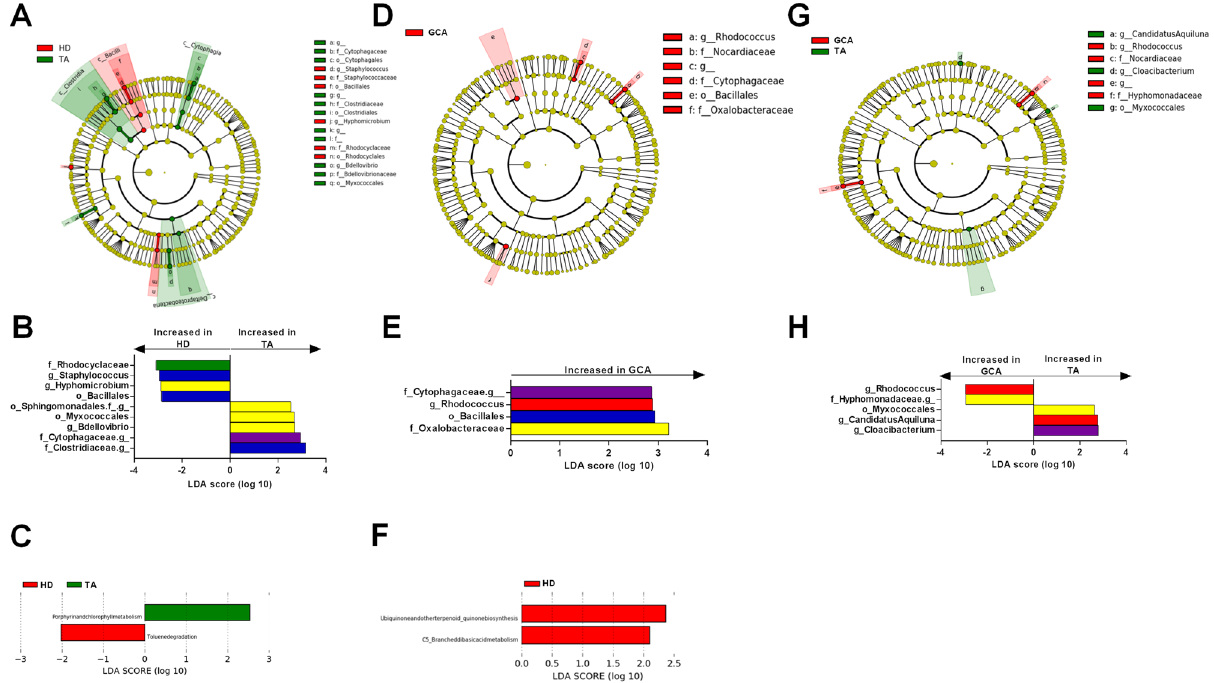
Figure 2. Circulating microbiome profile and predicted metagenomic function in patients with large vessel vasculitis depending on their phenotype. ( A ) LDA effect size (LEfSe) cladograms showing the taxa most differentially associated with TAK patients (n = 20) compared with HD patients (n = 15). ( B ) Specific changes in bacterial and fungal relative abundance between the two groups using LEFSe. ( C ) KEGG pathway contributions of predicted metagenomic data in TAK patients compared with HD patients. ( D ) LDA effect size (LEfSe) cladograms showing the taxa most differentially associated with GCA (n = 11) patients compared with HD patients (n = 15). ( E ) Specific changes in bacterial and fungal relative abundance between the two groups using LEFSe. ( F ) KEGG pathway contributions of predicted metagenomic data in GCA patients compared with HD patients. ( G ) LDA effect size (LEfSe) cladograms showing the taxa most differentially associated with GCA patients compared with TAK patients. ( H ) Specific changes in bacterial and fungal relative abundance between the two groups using LEFSe. LDA: Linear discriminant analysis. ( p < 0.05). (GCA, giant cell arteritis; TA, Takayasu’s arteritis; HD, healthy blood